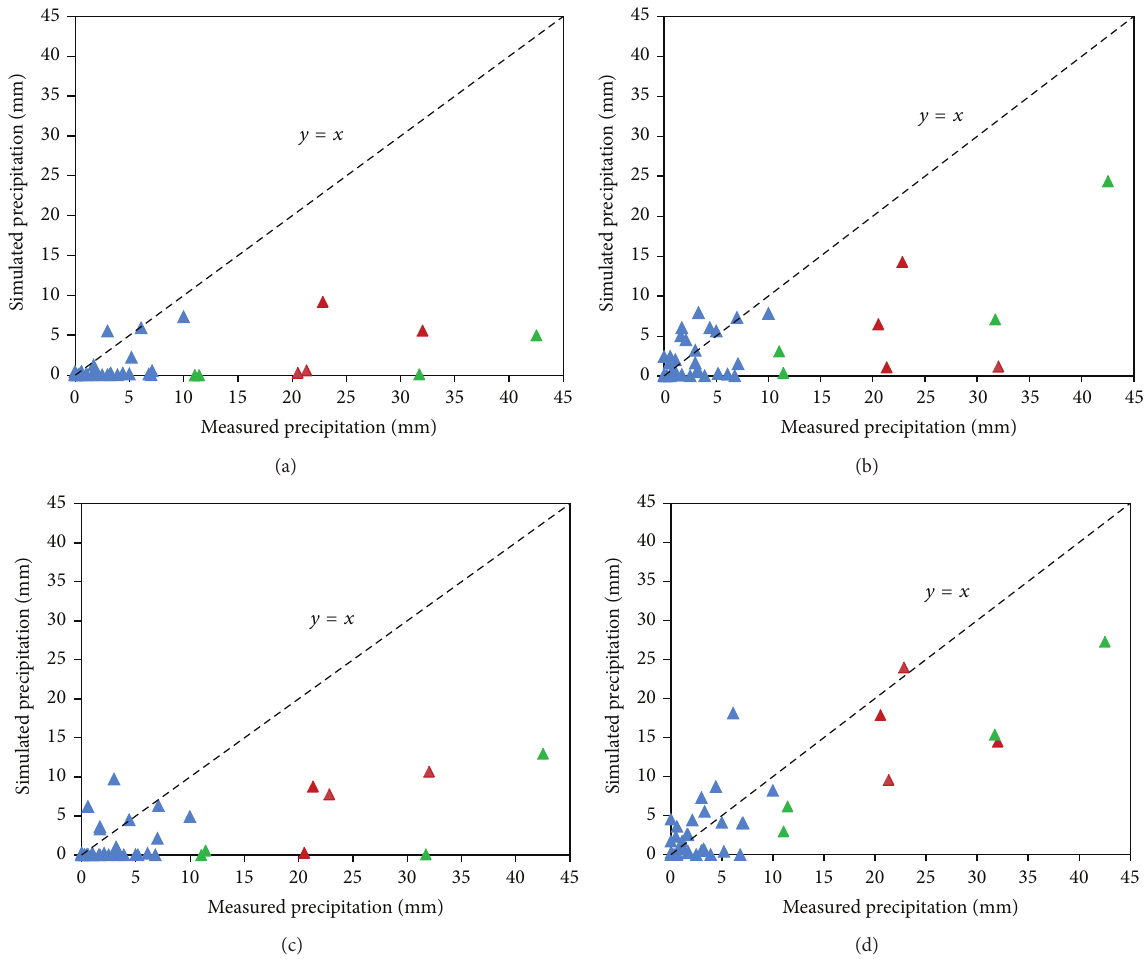
Figure 7: Differences between rainfall values measured at the sites and those from the numerical experiments for Event A: (a) CTRL; (b) DA-SAT; (c) DA-OBS; (d)